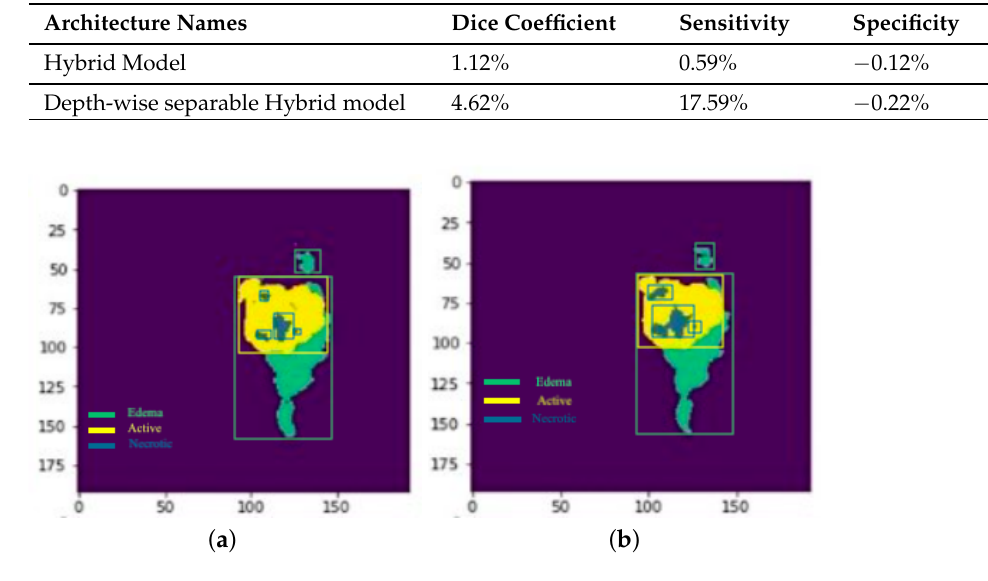
Figure 28. Results: Slice 1: ( a ) Actual result ( b ) Predicted result.